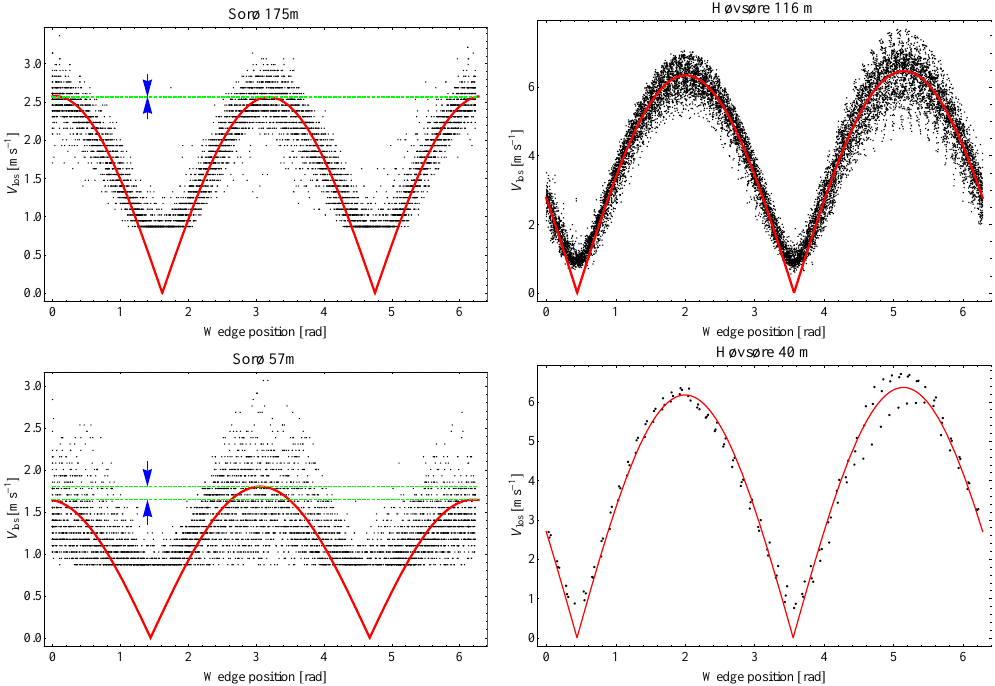
Fig. 1. Examples of lidar line-of-sight velocities from conical scanning mode. The two plots from Sorø and the 116m plot from Høvsøre show the line-of-sight velocities for a 30min period and the 40m Høvsøre plot illustrate data from a 3s scan. The peaks of the fit (Eq. 3, thick red line) define the wind speed in the mean wind direction, and the difference in the peak heights show the mean vertical velocity for homogeneous